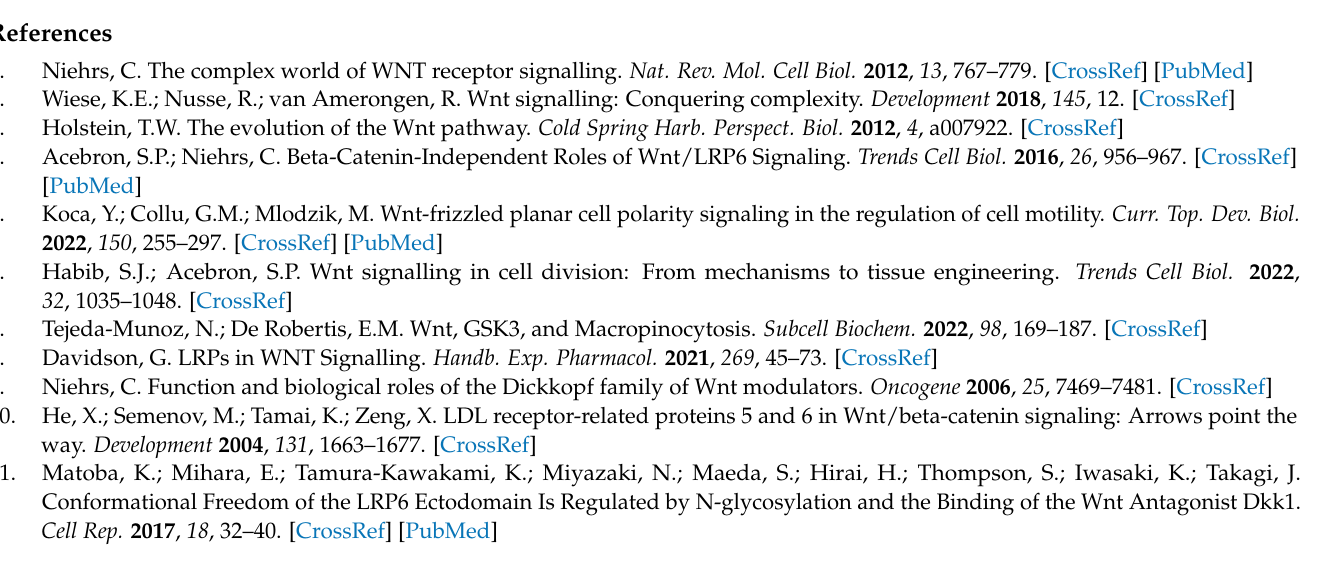
to Figure 1. Figure S2: Supplementary information pertaining to Figure 2. Figure S3: Supplementary information pertaining to Figure 3. Figure S4: Supplementary information pertaining to Figure 4. Figure S5: Supplementary information pertaining to Figure